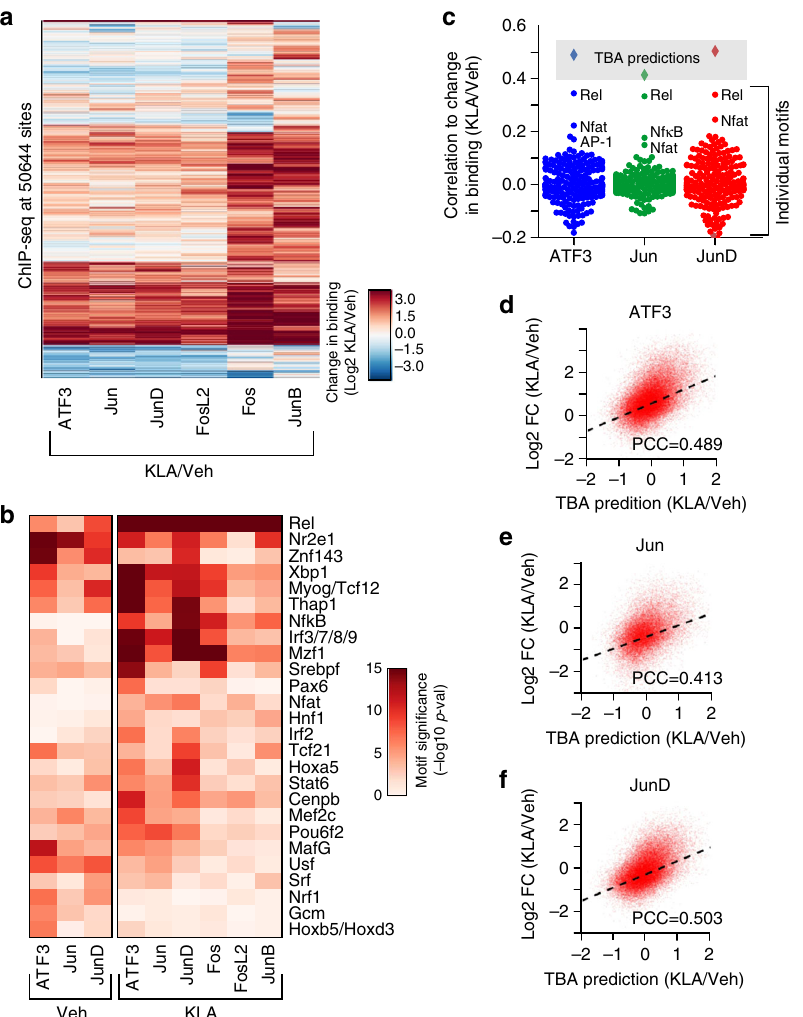
Fig. 5 AP-1 binding is context-dependent and affected by the availability of binding partners. a Heatmap of the change in binding of AP-1 monomers after 1- h Kdo2 lipid A (KLA) treatment quanti fi ed as the Log2 ratio of KLA binding to Vehicle binding. b Heatmap showing the transcription factor binding analysis (TBA) assigned signi fi cance of DNA motifs that had a 10e4 absolute likelihood ratio between the KLA and Vehicle value for each monomer. c Pearson correlation of individual motif scores and TBA predictions with the change in binding after 1 h KLA treatment. d – f TBA predicted change in ATF3, Jun, and JunD binding after KLA-1 h treatment versus actual change in binding. PCC indicates the Pearson correlation coef fi cient of TBA predictions to the log2 fold change in binding of each monomer after 1 h KLA